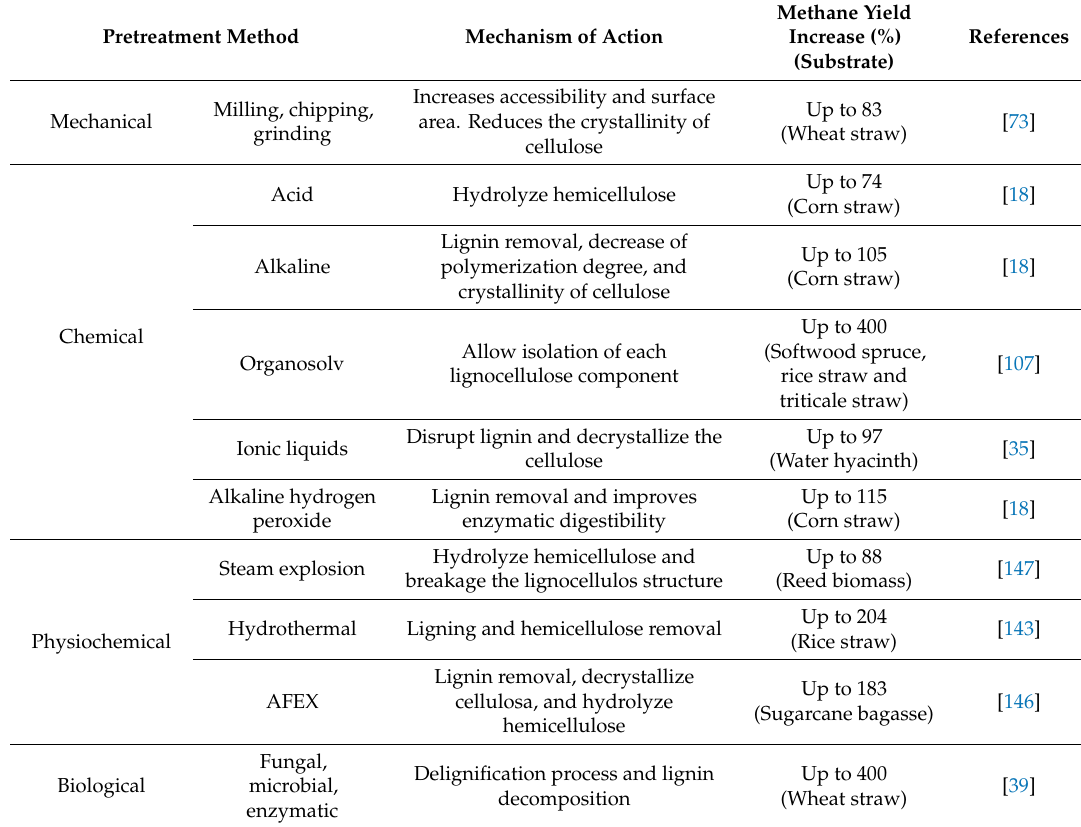
A brief summary on the e ff ect of pretreatment methods on methane yield from lignocellulosic